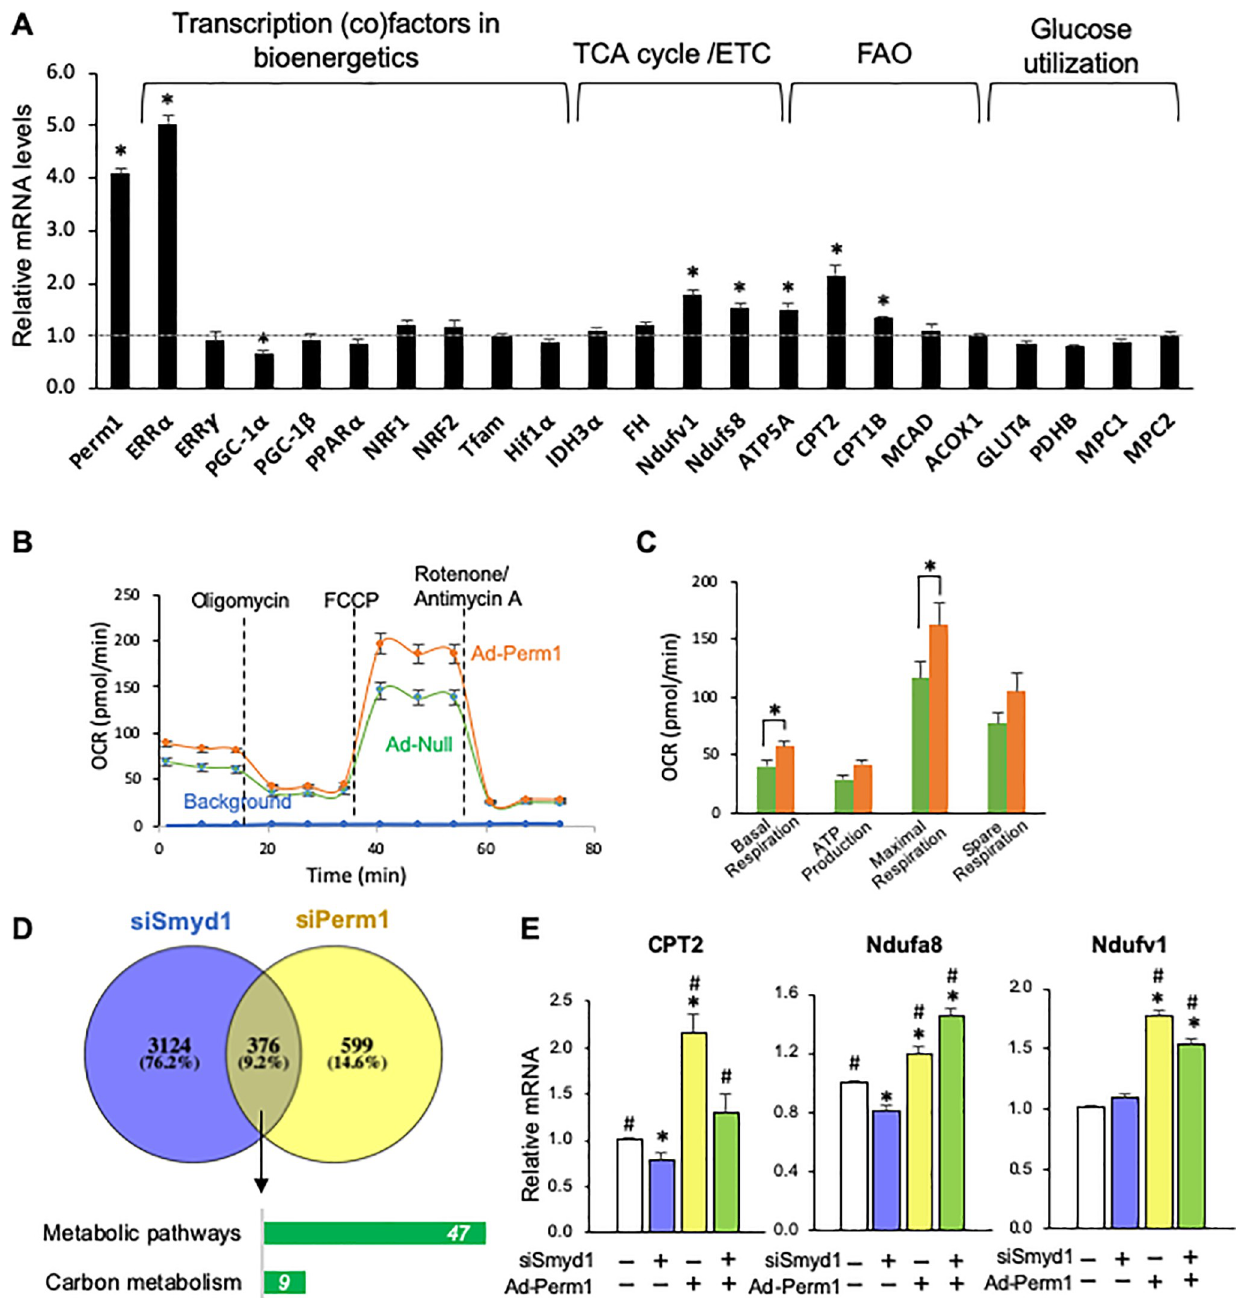
Fig 4. Adenovirus-mediated overexpression of Perm1 (Ad-Perm1) enhances energetics in cardiomyocytes, partially mediated by Smyd1. (A) qRT-PCR showing the expression of genes involved in energetics (n = 4/group). Statistics were performed using the t-test with 2 tails. � p < 0.05. ( B) Cell Mito Stress Test was performed using a Seahorse XF96 analyzer in NRVMs (n = 8/group, ± SD). O 2 consumption rate (OCR) was measured in the presence of glucose as a major respiration substrate. (C) Results were normalized by nuclear staining as described in our publication [2]. Error bars are ± SEM. Statistics were performed using the t-test with 2 tails. � p < 0.05, ( D) A Venn diagram showing the genes downregulated in both siSmyd1 and siPerm1 NRVMs that were detected in RNA-seq (top). The overlaping genes were further analyzed by KEGG pathway analysis (bottom). ( E) qRT-PCR shows that siSmyd1 downregulated CPT2 and Ndufa8 , both of which were completely rescued by Perm1overexpression (Ad-Perm1). In contrast, Ndufv1 expression was not affected by siSmyd1, suggesting that Ndufv1 is not a Smyd1 target gene. Ndufv1 was upregulated by Ad-Perm1 in the presene and absence of siSmyd1 (n = 3-5/group, t-test). � : p < 0.05 compared with control, #: p < 0.05 compared with siSmyd1. Statistics were performed using one-way ANOVA. Error bars are ± SEM.